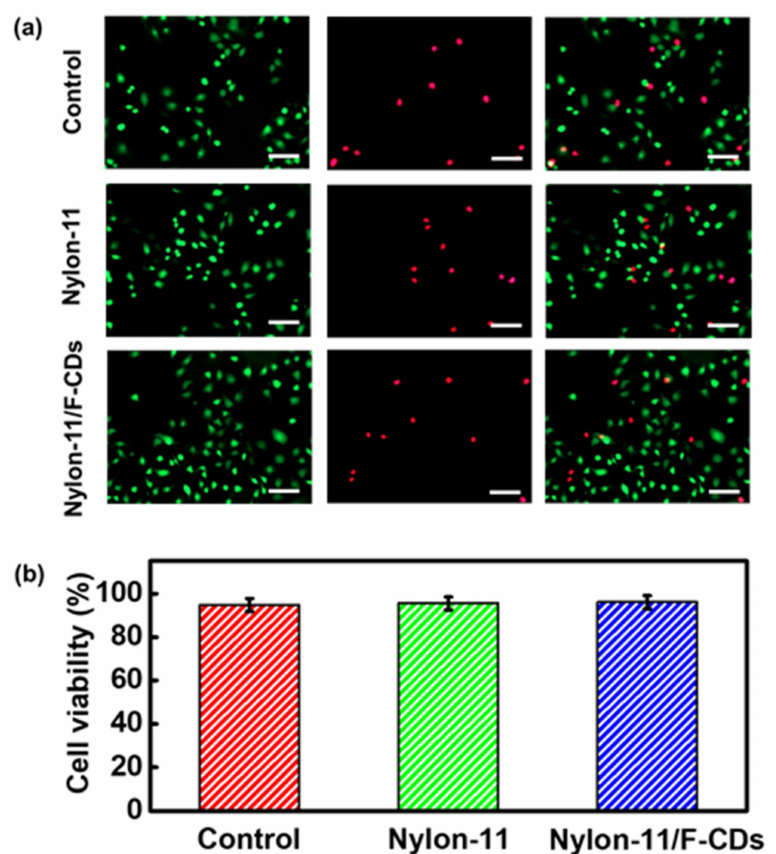
Figure 7. ( a ) Fluorescence microscope images of control, Nylon-11, Nylon-11/F-CDs with encapsula- tion of live/dead staining L-929 cells after culturing for 3 days. Red and green colors represent dead and live cells, respectively. Scale bar = 100 µ m. ( b ) Relative survival of L-929 cells after culturing for 3 days for control, Nylon-11, and Nylon11/F-CD